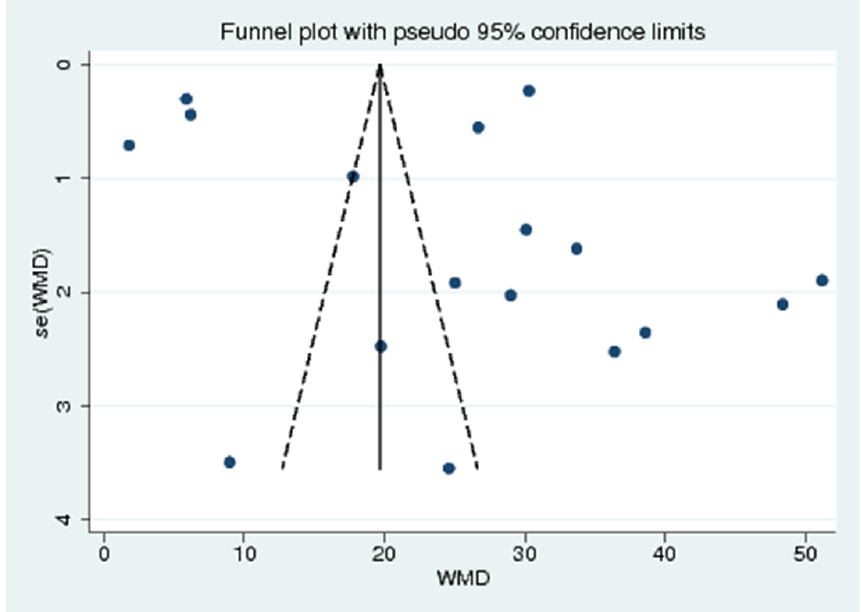
Figure 10. Funnel plot. WMD: Weighted Mean Difference, se (WMD): Standard Error (Weighted Mean Difference)